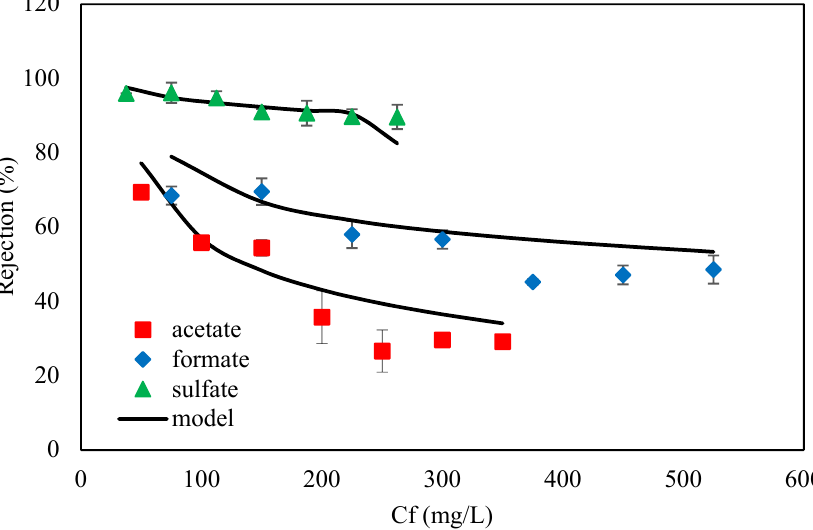
Figure 5. Comparison of the experimental data with the obtained results of the mathematical equations reported for acetate, formate, and sulfate in the NF-3 membrane at 35 °C and 70 bar.